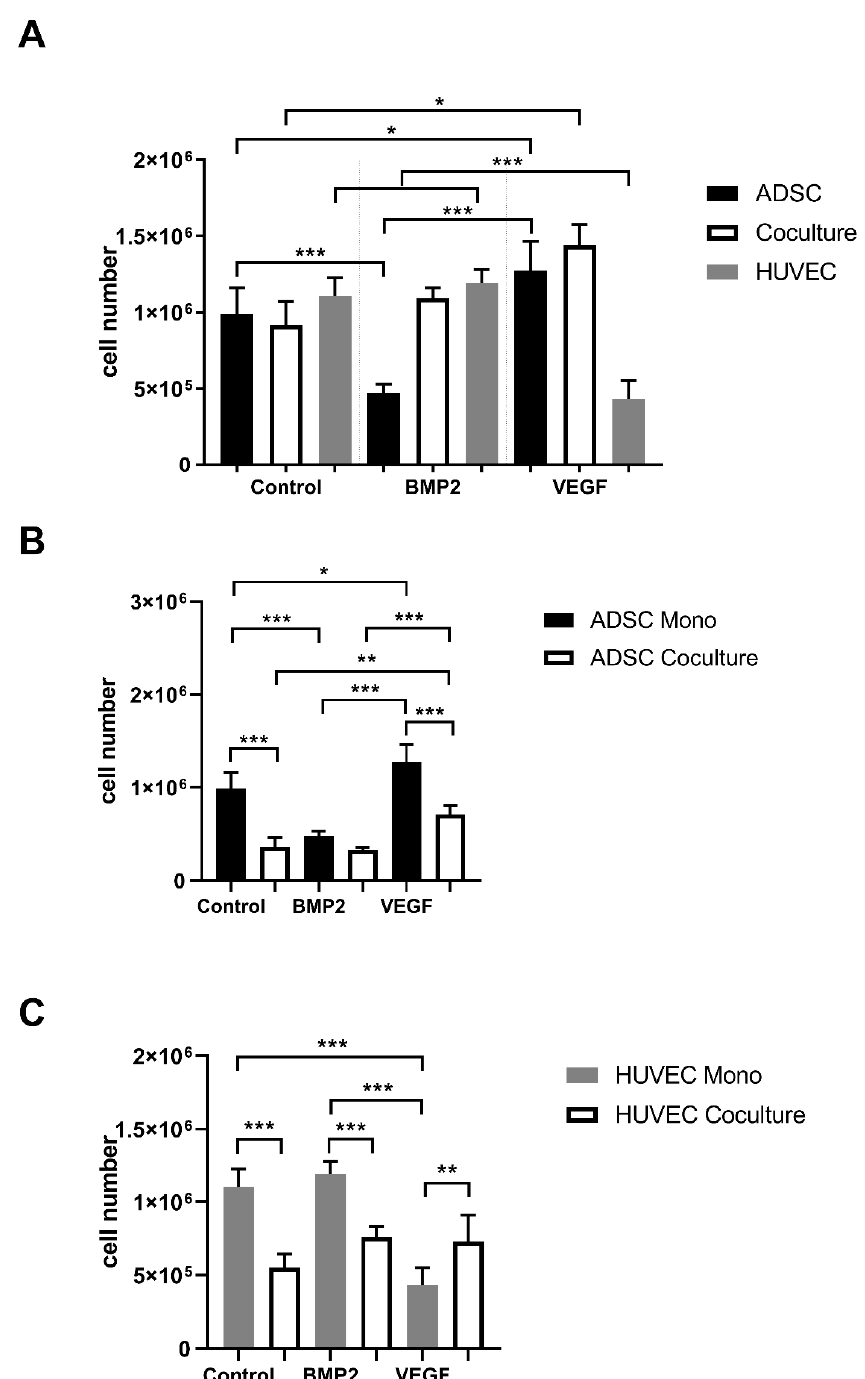
Figure 1. Proliferation rate of ADSCs and HUVECs under mono- and coculture conditions. After adding VEGFA165, a statistically significant increase of the total cell number was detected in the ADSC monoculture as well in the coculture group ( A ). Using negative immunoselection, the effects of BMP2 or VEGFA165 were observed cell type specific ( B , C ). Statistically significant differences between the experimental groups are indicated for * p ≤ 0.05, ** p ≤ 0.01 and *** p ≤ 0.001.